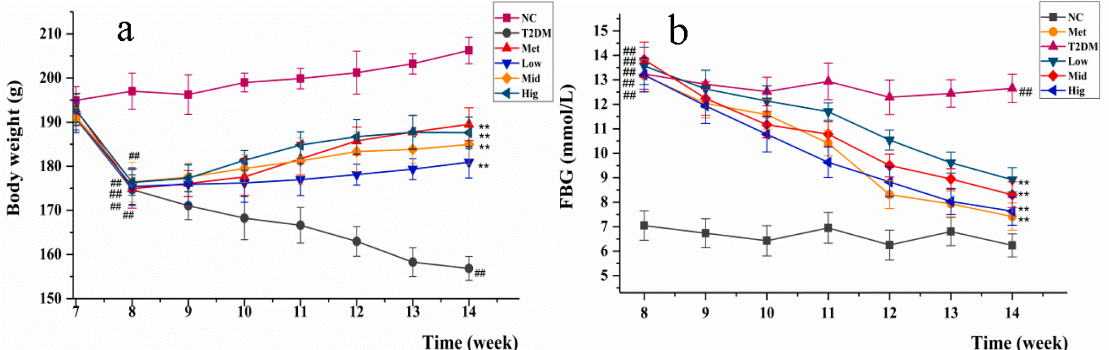
Figure 2. The changes in body weight ( a ) and fasting blood glucose (FBG) ( b ) of rats during the administration of Met and purified anthraquinone-Glycoside from Rheum palmatum L. (PAGR). NC, normal group; T2DM, type 2 diabetes mellitus; Met, metformin group; Low, low group (100 mg / kg); Mid, middle group (200 mg / kg); Hig, high group (400 mg / kg). The data were expressed as mean ± standard deviation (SD) ( n = 10), # p < 0.05 ## p < 0.01 vs.NC group; * p < 0.05 ** p < 0.01 vs. T2DM